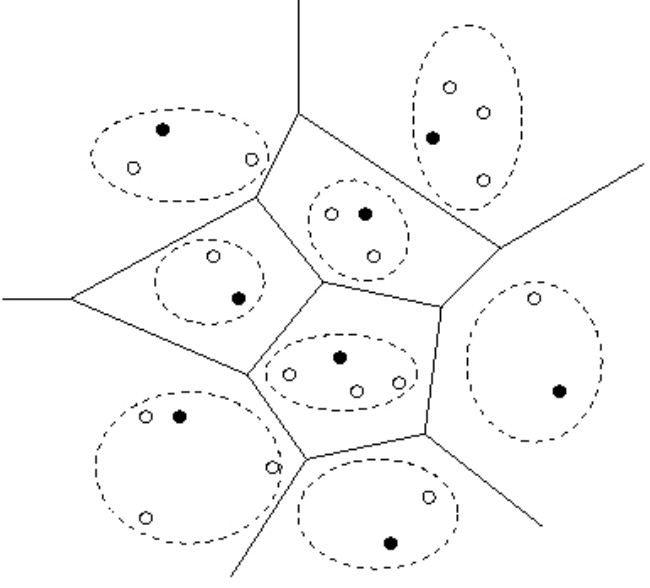
Figure 2. k -clustering using Voronoi diagrams. Clusters are denoted by dashed